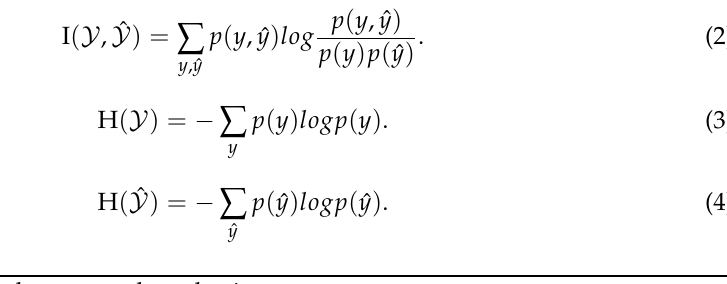
Algorithm 1 Adaptive class exemplar